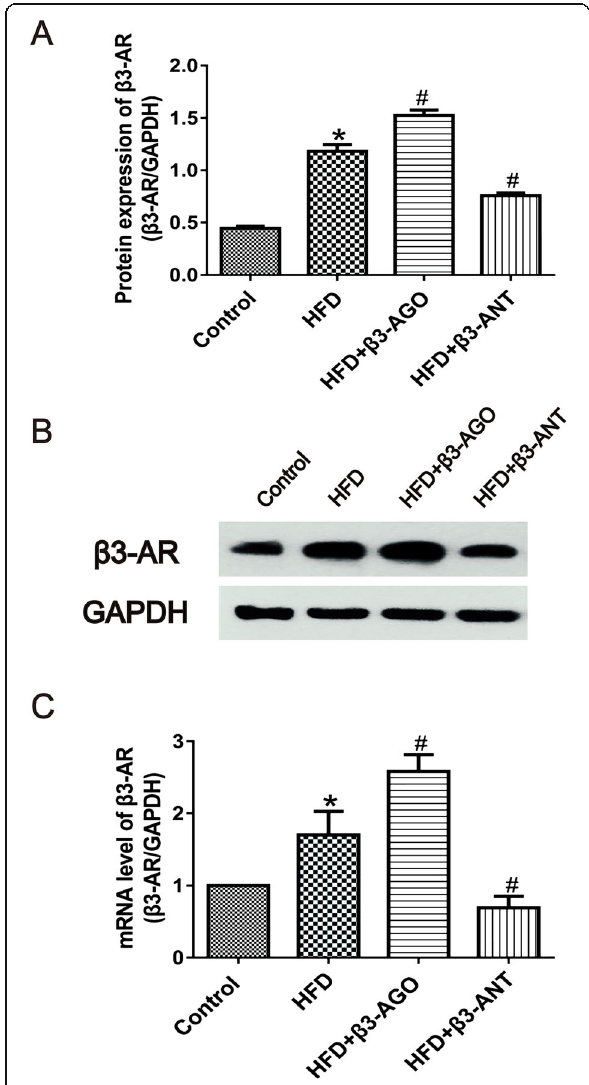
Fig. 1 Protein and mRNA expression of β 3-AR in the liver in the four groups. a Quantitative analysis of β 3-AR protein levels relative to GAPDH levels (each group, n = 8). b Western blot analysis of β 3-AR protein levels using specific β 3-AR antibodies. GAPDH was used as a loading control. c β 3-AR mRNA expression in the control, HFD, HFD + β 3-AGO and HFD + β 3-ANT groups (each group, n = 8). β 3- AGO refers to the β 3-AR agonist BRL37344, and β 3-ANT refers to the β 3-AR antagonist L748337. * P < 0.05 vs the control group, # P < 0.05 vs the HFD